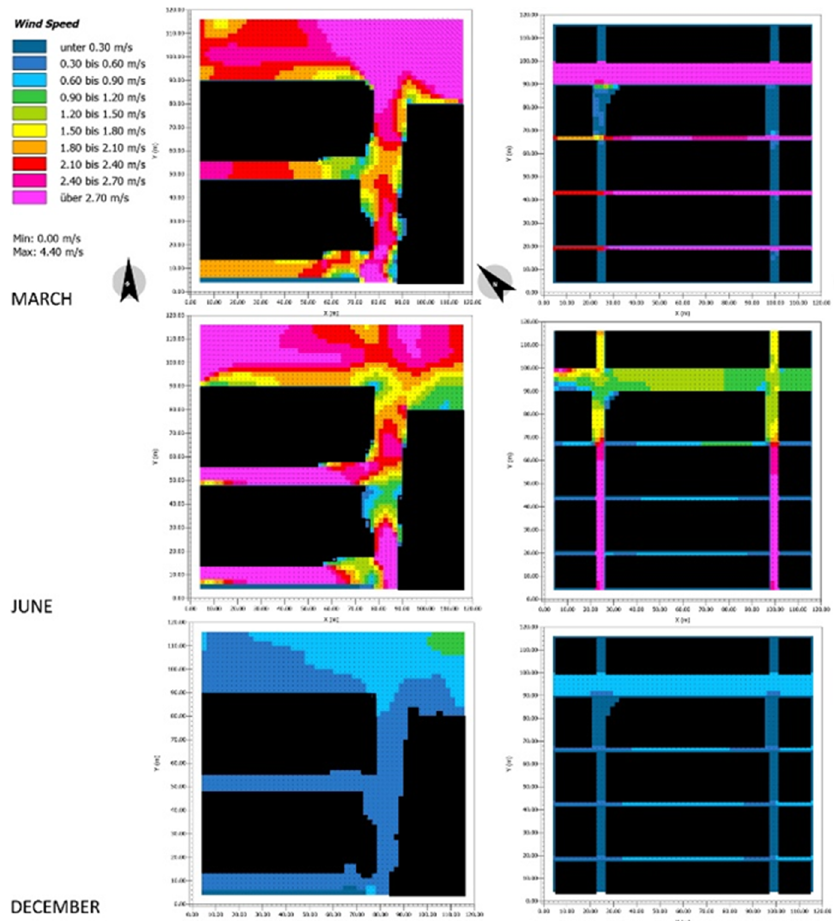
Figure 16. Air pattern of the two studied urban pattern types.